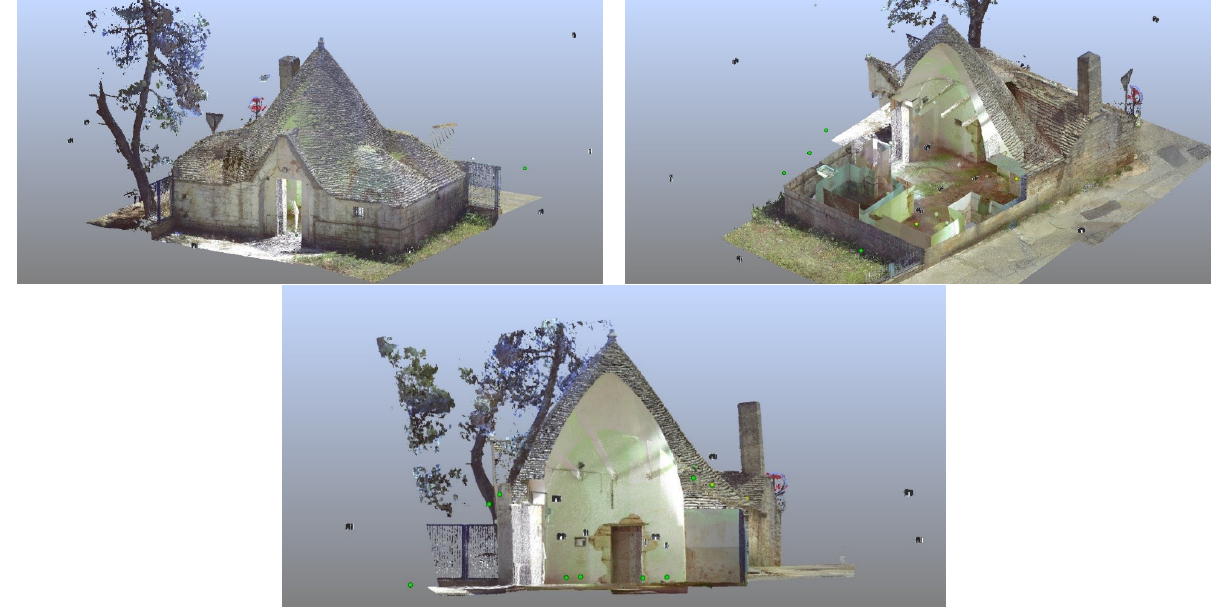
Figure 7: The cloud of points obtained from the 3D-laser scanner survey.